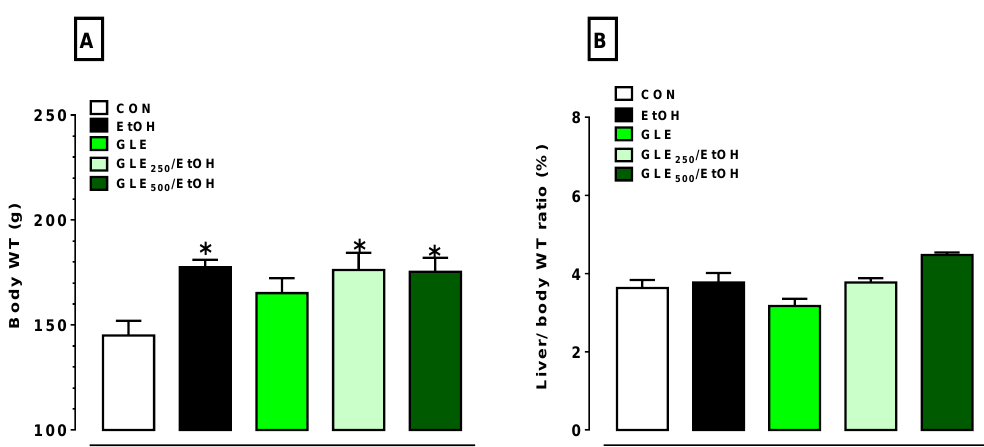
Figure 2. GLE effects on body weight and liver coefficient in EtOH-treated rats. Bar graphs show changes in ( A ) body weight and ( B ) liver coefficient. Liver coefficients were calculated according to formula of liver coefficient (%) = (liver weight)/(body weight) × 100. Data expressed as mean ± SEM (n = 5–8). * p < 0.05 compared to control using one-way analysis of variance (ANOVA) followed by